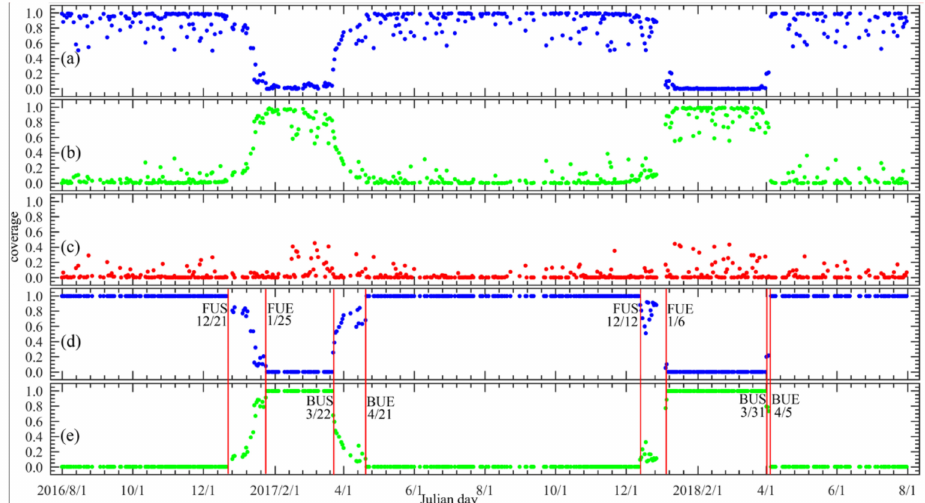
Figure 6. Water coverage, ice coverage, and cloud coverage for the two full ice season periods from 1 August 2016 to 31 July 2018 (( a ). water coverage; ( b ). ice coverage; ( c ). cloud coverage; ( d ). water coverage through cloud filtering; ( e ). ice coverage through cloud filtering. Blue dot, green dot, and red dot represent water, ice, and cloud,